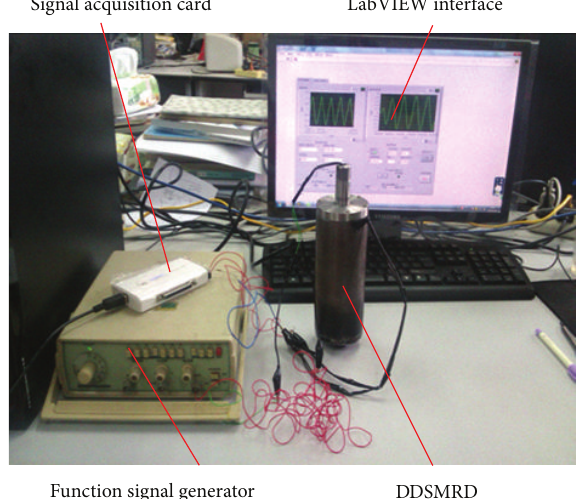
Figure 7: Signal acquisition system of self-induced